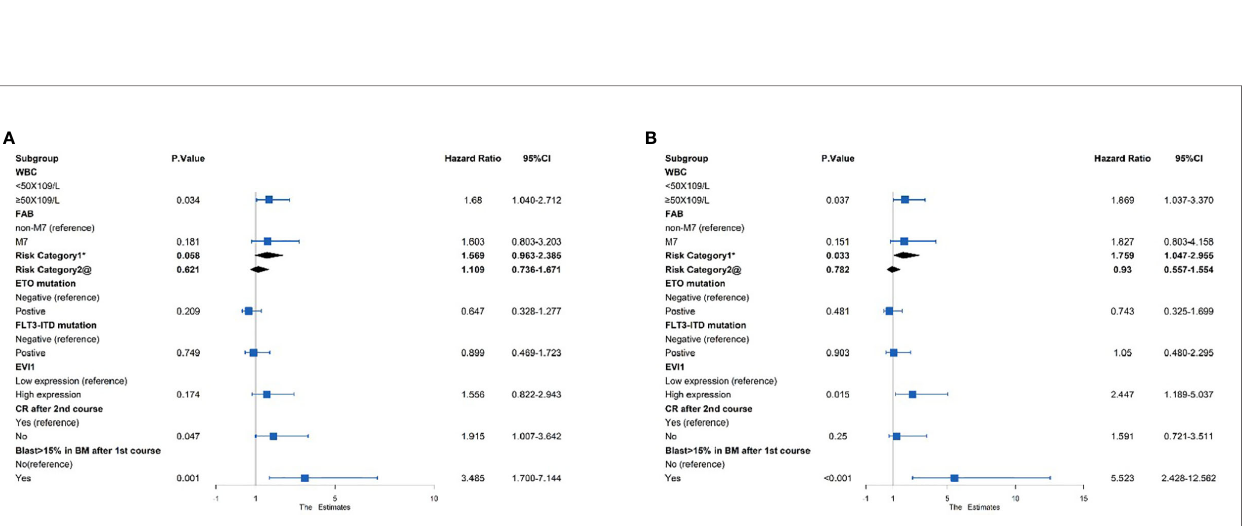
FIGURE 3 | Multivariate Cox regression analysis of the (A) EFS and (B) OS among 383 pediatric AML patients. *Risk category based on treatment regimens. Refer to Supplementary Table S1 . @ Risk category based on cytogenetic strati fi cation of ELN 2017.